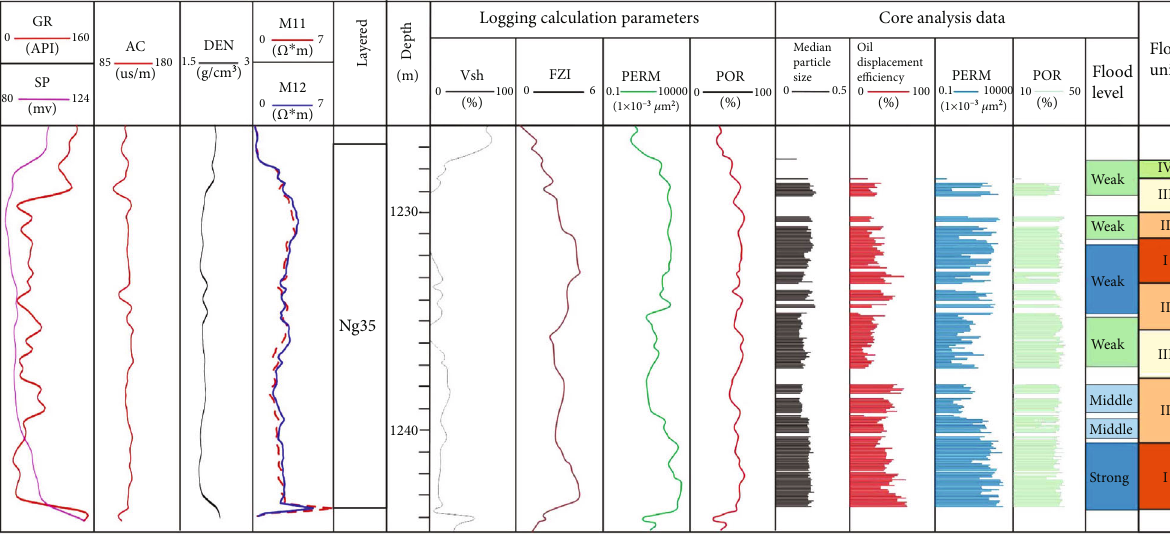
Figure 4: Comprehensive column division of fl ow unit in